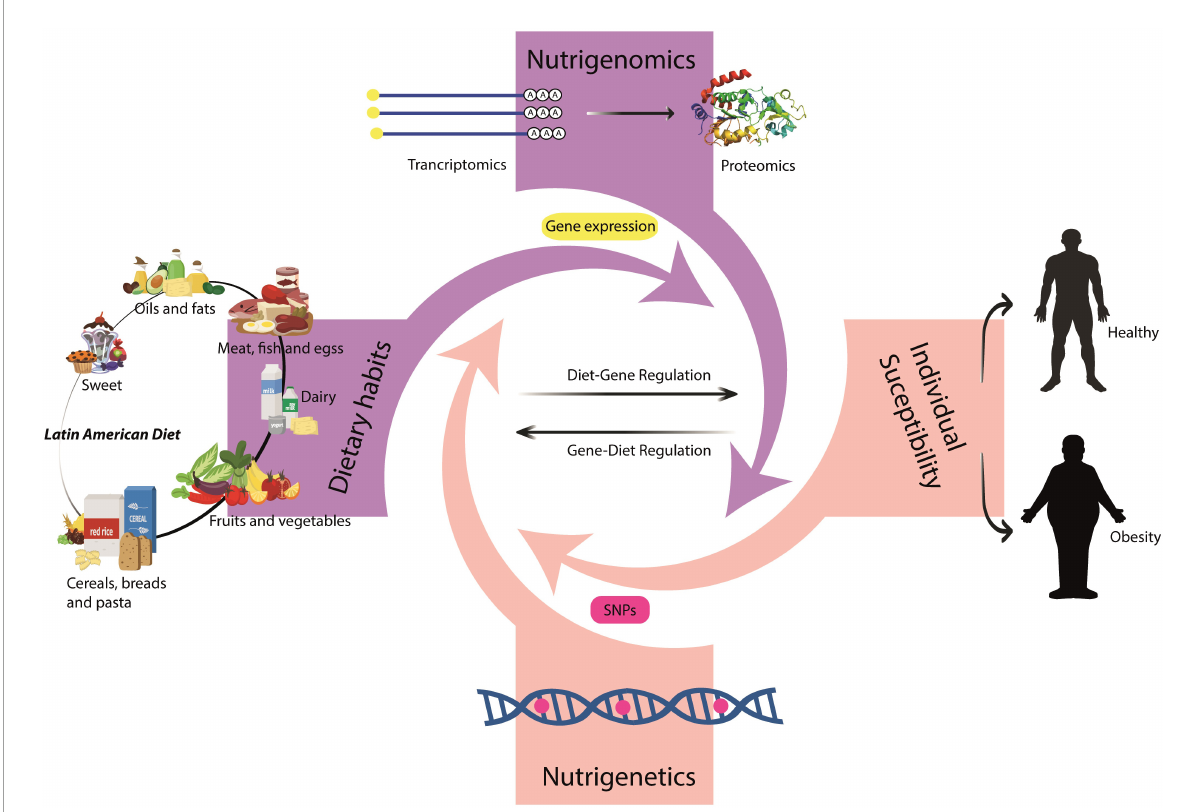
FIGURE1 Nutrigenetics, nutrigenomics, dietary habits, and individual susceptibility. Nutrigenetics studies genetic variations (SNPs) and their effect on dietary response. Nutrigenomics studies the role that the nutrients have on gene expression with a focus on the Latin American environment. Collectively, these three factors could increase or decrease an individual’s susceptibility to develop obesity in Latin